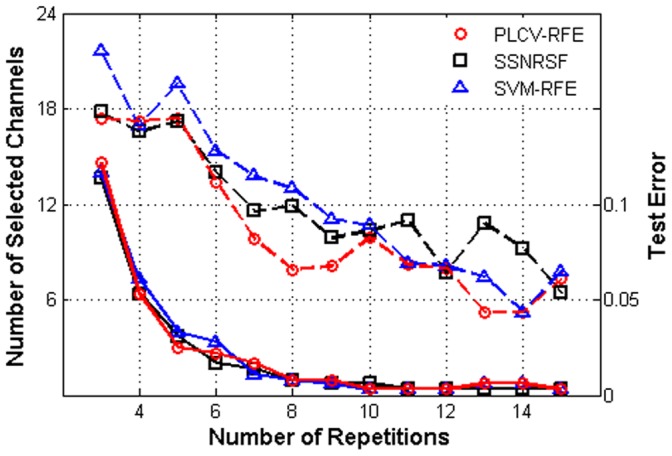
The comparison of optimal channel subsets.The number of OCS channels against the number of repetitions is displayed by dash lines with different methods. The corresponding CREs are illustrated by solid lines.